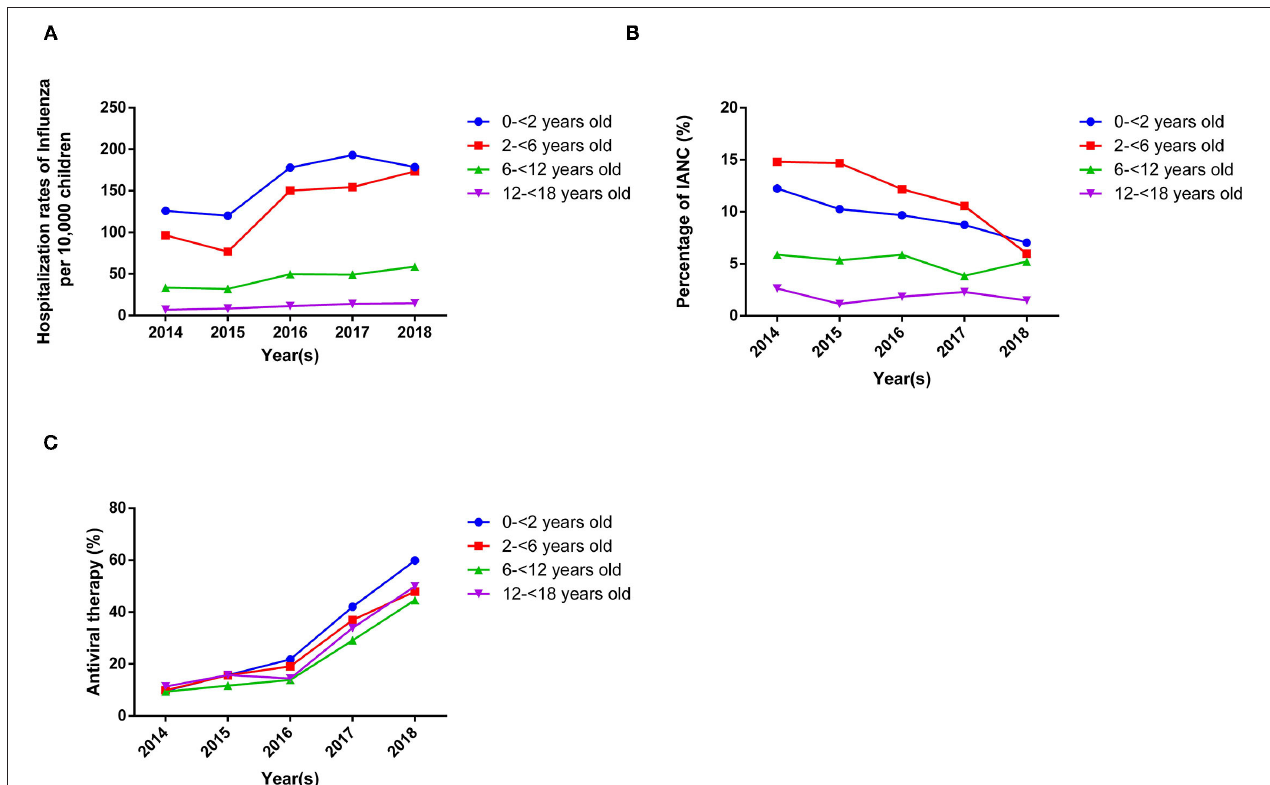
FIGURE 1 | The hospitalisation rate, the percentage of IANCs, and the use of anti-viral therapy in paediatric in-patients diagnosed to have influenza A or B infection during the study period 2014 to 2018. (A) . The hospitalisation rate of paediatric patients with influenza A or B increased from 2014 to 2018 for all age groups. (B) The percentage of total IANCs in the admitted paediatric patients ( < 18 years old) with influenza A or B infection decreased from 2014 to 2018 for all age groups. (C) The percentage of anti-viral therapy (oseltamivir) in admitted paediatric patients ( < 18 years old) with influenza A or B infection increased from 2014 to 2018 for all age